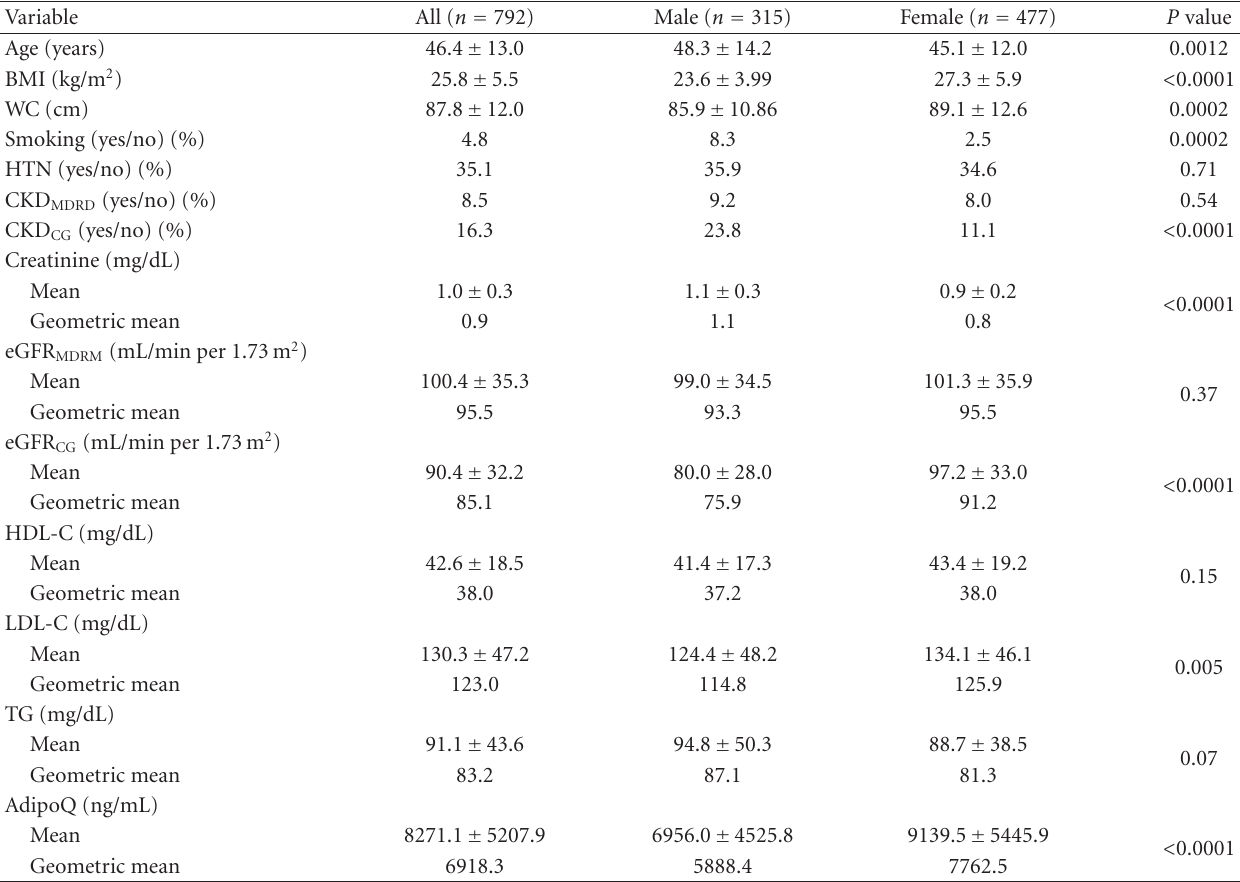
Table 1: Anthropometric and clinical characteristics of study sample. (a) Participant characteristics categorized by